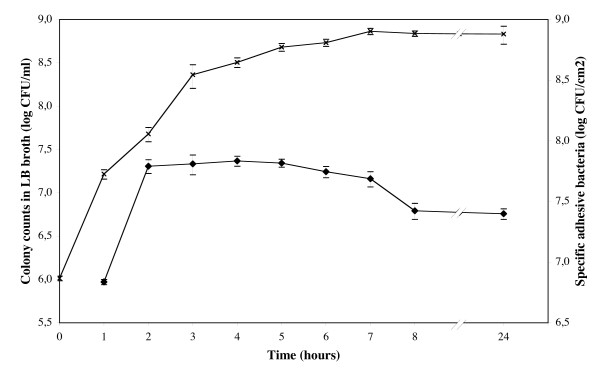
Effect of growth phase on adhesion of E. sakazakii strain ES5 to HEp-2 cells. The data represent the statistical means of three experiments. Symbols: *, colony counts in LB broth (log CFU/ml); •, number of specific adhesive bacteria (CFU per cm2 of Hep-2 tissue culture).